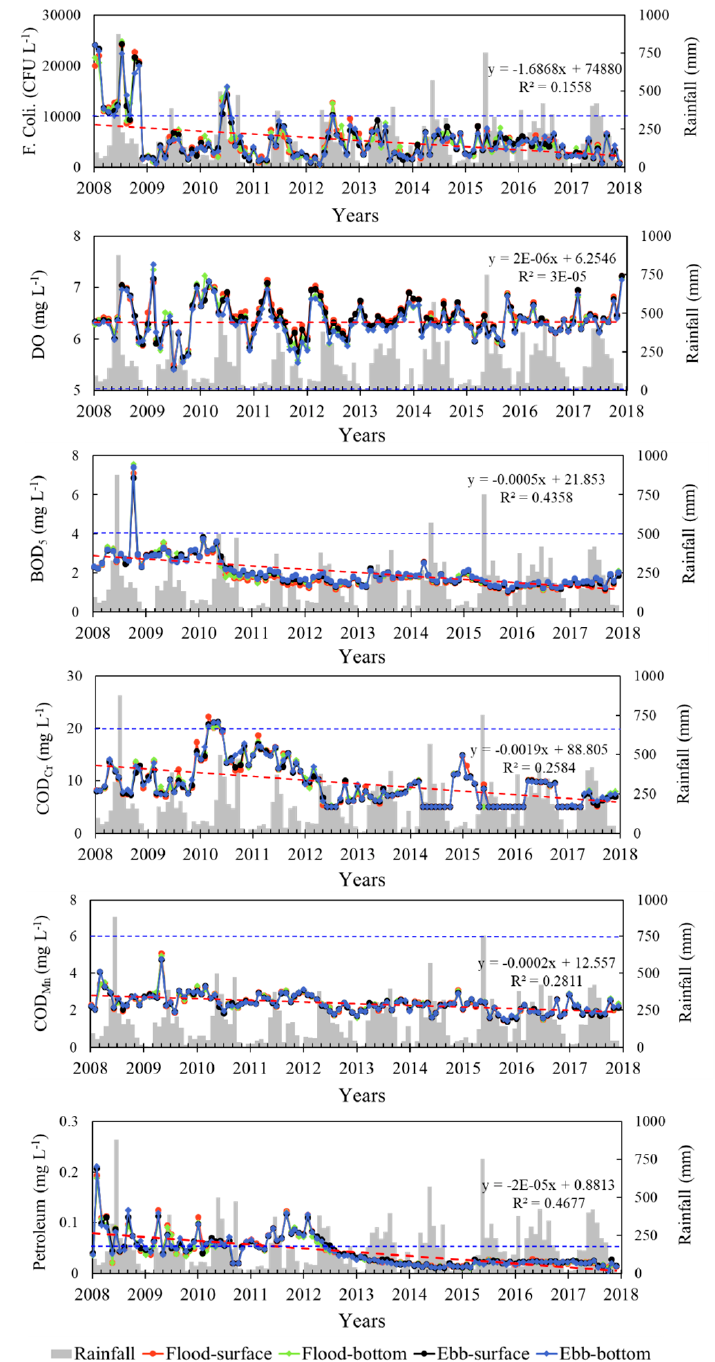
Figure 2. Temporal changes in fecal coliform (F. Coli), dissolved oxygen (DO), biochemical oxygen demand (BOD 5 ), chemical oxygen demand (COD Cr ), potassium permanganate index (COD Mn ) and petroleum in the estuarine water measured from six sites (given as mean) in Nansha, Guangzhou, over the ten-year period (2008–2017). Rainfall data are presented as the background information. The red dashed lines refer to the trendlines with equations and R 2 provided. The blue dashed lines refer to the Chinese environmental quality Class III standards for surface